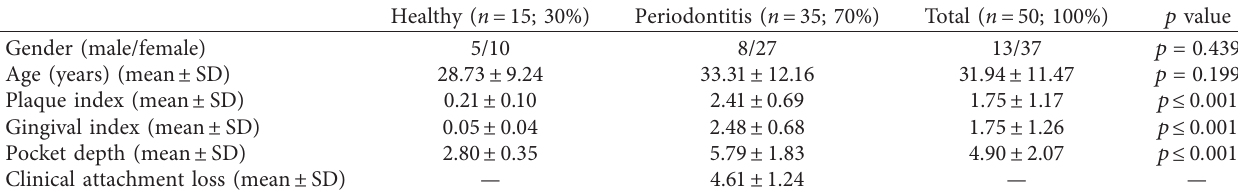
Table 1: Demographic and clinical characteristics of the study population.